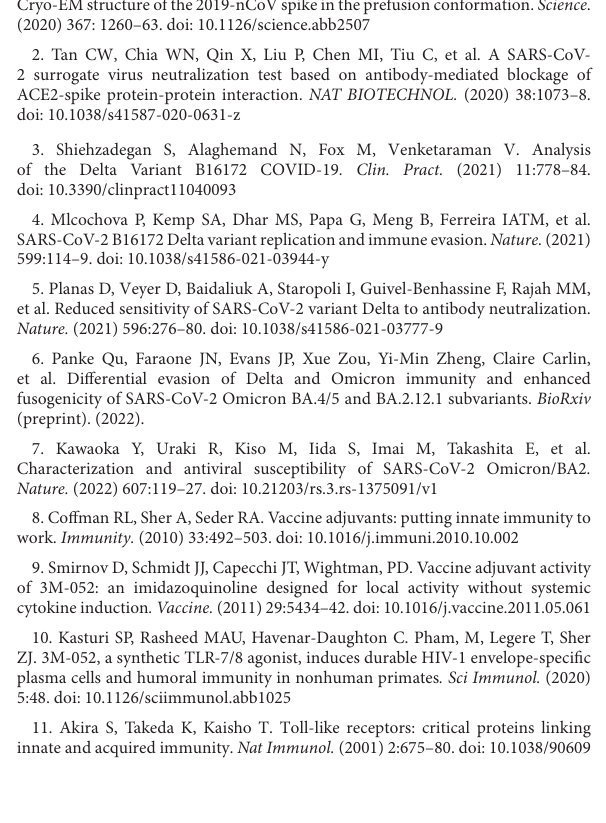
SUPPLEMENTARYDATA2 Data of mice serum IgM antibody titers against spike protein (B.1.617.2). SUPPLEMENTARYDATA3 Data of inhibition rates of mice serum neutralizing antibody against SARS-CoV-2 spike protein (B.1.617.2). SUPPLEMENTARYDATA4 Data of neutralization efficiencies of mice serum neutralizing antibodies against pseudovirus of SARS-CoV-2 (B.1.617.2) and SARS-CoV-2